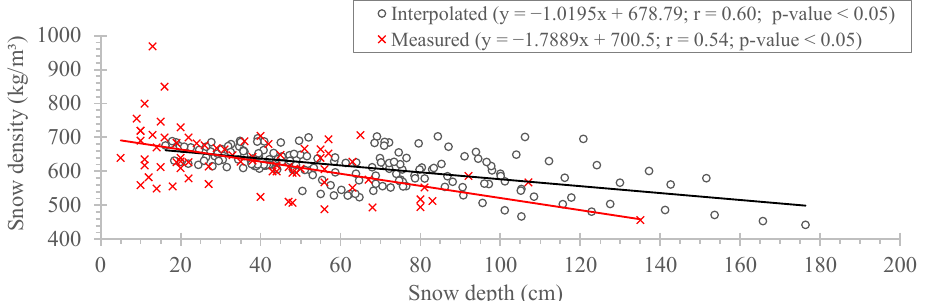
Figure 7. Correlation between measured values on 5 March 2015, (red line) and correlation between the mean depth and density of the interpolated ski piste snowpack on the basis of 181 concentric circles around snow lances. Correlation coefficients (r) and p -values from analysis of variance (ANOVA) are displayed.